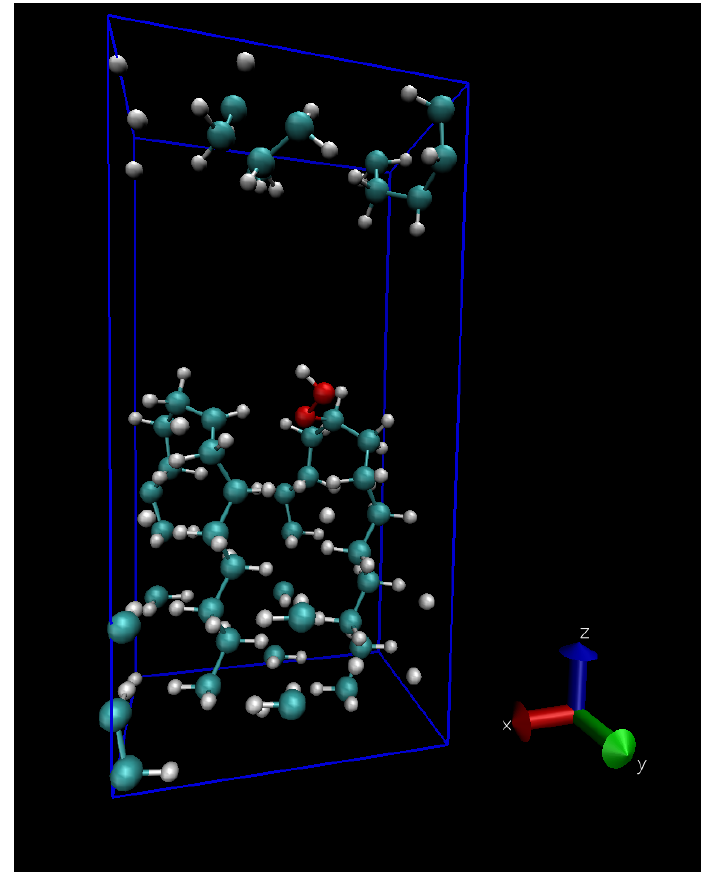
Figure 1. The periodically repeated 133-atom unit cell used to mimick the interface between two crystalline lamellæ of PE, here with a